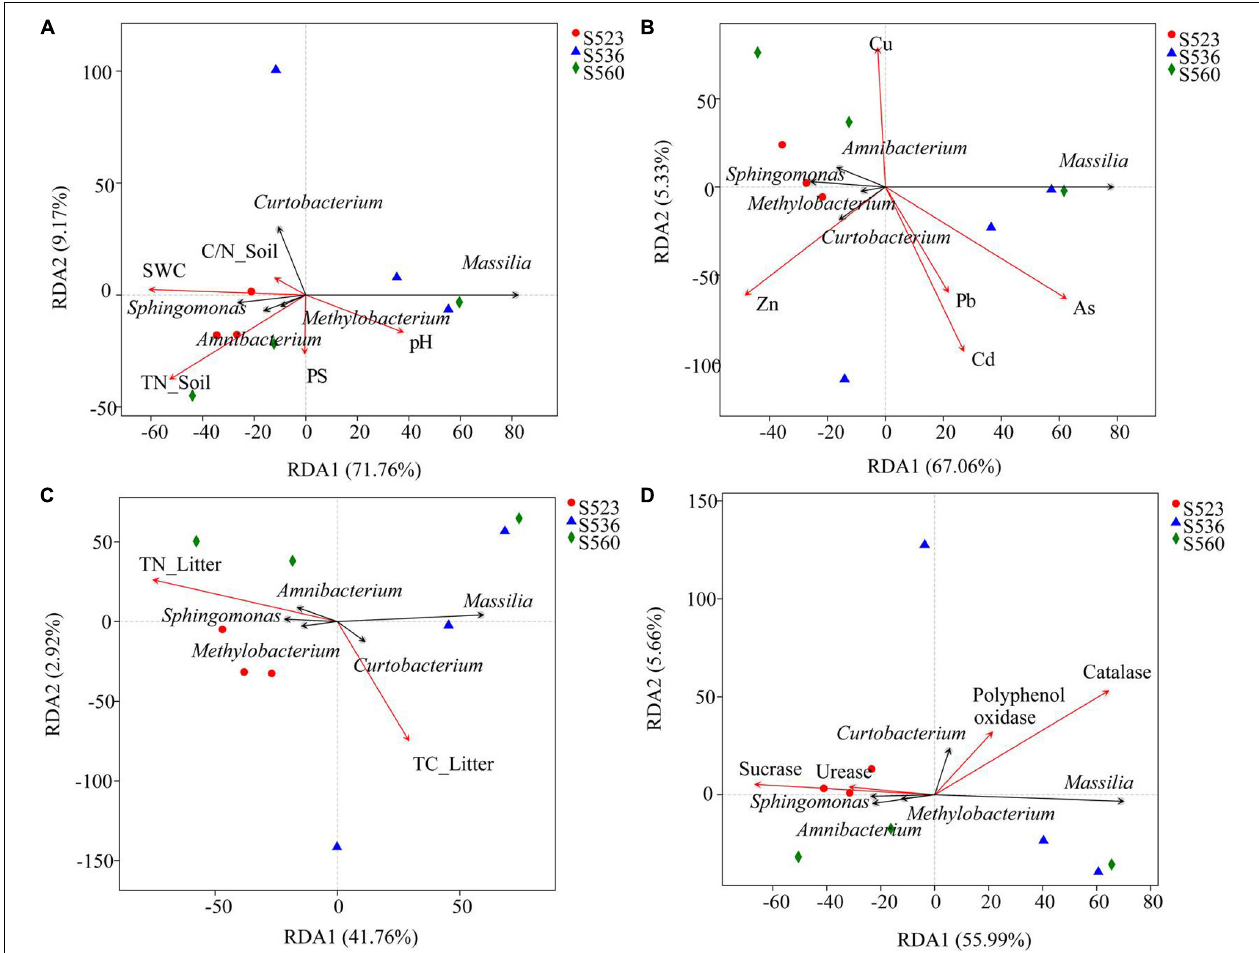
FIGURE 5 | Redundancy analysis (RDA) of bacterial communities and environmental factors. Environmental factors include soil properties (A) , heavy metals (B) , litter properties (C) , and enzyme activities in litter (D) , represented by red arrows. The black arrows represent the top five bacterium at a genus